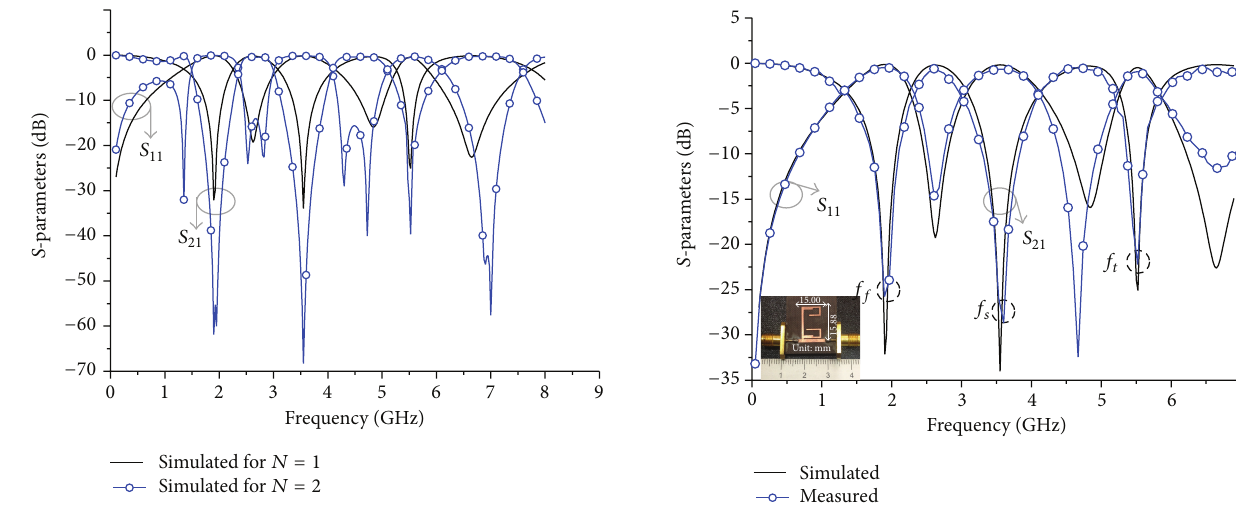
Figure 9: Simulated results of the proposed TBBSFs for different orders of 𝑁 = 1 and 𝑁 = 2 . Table 1: Performance comparison of simulated and measured results of the proposed TBBSF.